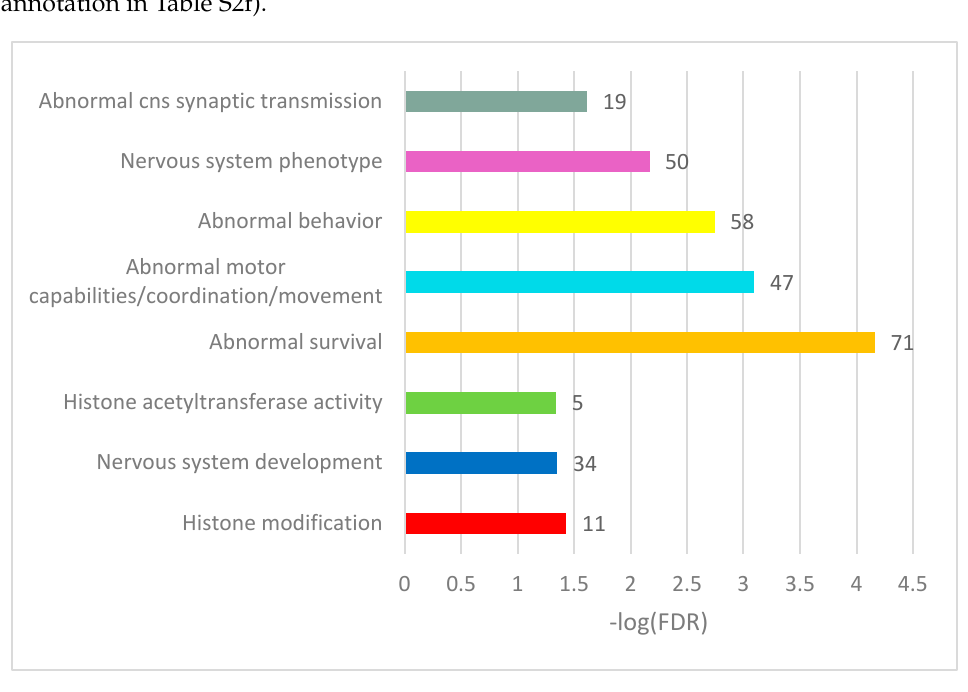
Figure 4. Volcano plots of the differential expression of DAS ES genes (Table S2a) created by Xlstat software (XLStat.com). ( a ) DEGs Log fold change in AD vs control groups comparison; ( b ) DEGs Log fold change in AD vs control groups comparison; ( c ) DEGs Log fold change in A20 vs AD groups comparison. Golgb1 gene is Golgin b1 Golgi autoantigen and Zbed6 is Zinc Finger BED Do- main-Containing Protein 6.